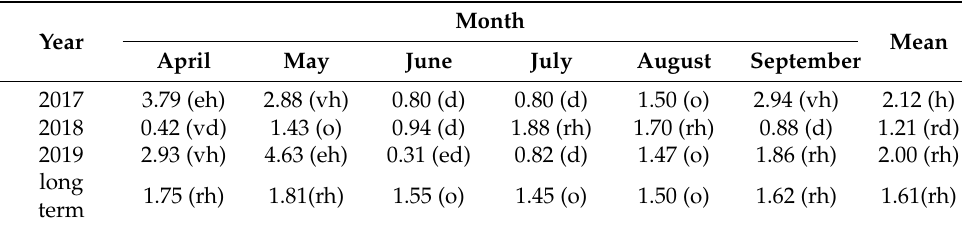
Figure 1. Mean monthly air temperature and precipitation in 2016–2019. Table 3. Sielianinov’s hydrothermic coefficients (k) in the growing season .